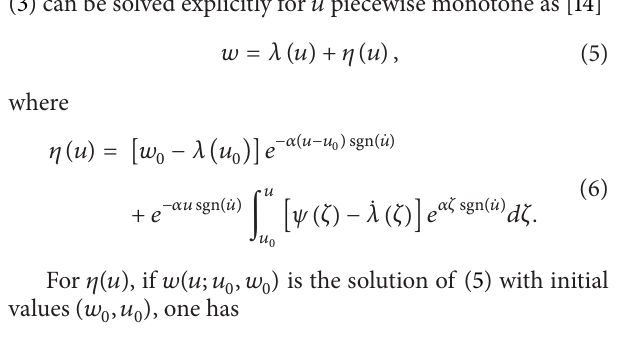
satisfying three properties; the described hysteresis curves are shown in Figures 1 and 2.